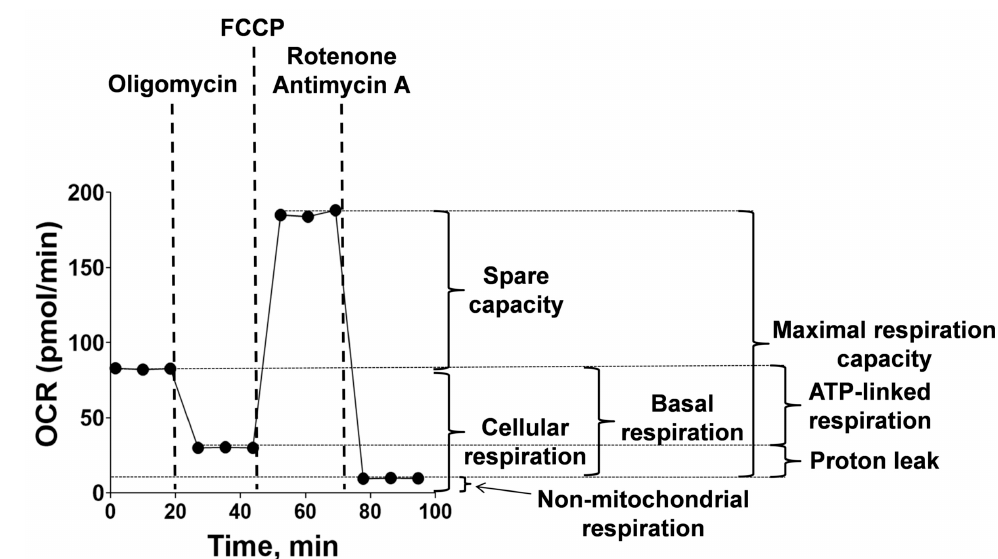
Figure 5. Scheme for measuring the bioenergetics parameters. Seahorse technology was used to assess cellular OCR. The ATP synthase inhibitor oligomycin, protonophore FCCP (carbonyl cyanide 4-(trifluoromethoxy)phenylhydrazone), and mitochondrial complex I and III inhibitors, Rotenone and antimycin A, respectively, were used to further determine indicators of cellular respiration. OCR is the oxygen consumption rate. ECAR is the extracellular acidification rate. The res- piration parameters were calculated as follows: Basal respiration = cellular respira- tion—non-mitochondrial tion—oligomycin-inhibited respiration; Maximal respiration capacity = FCCP-induced respira-